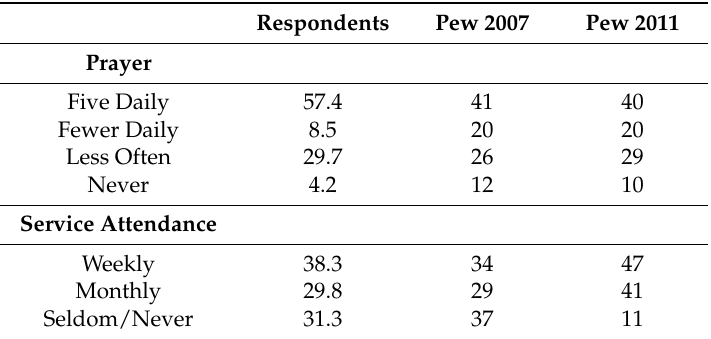
Table 1. Religiousity